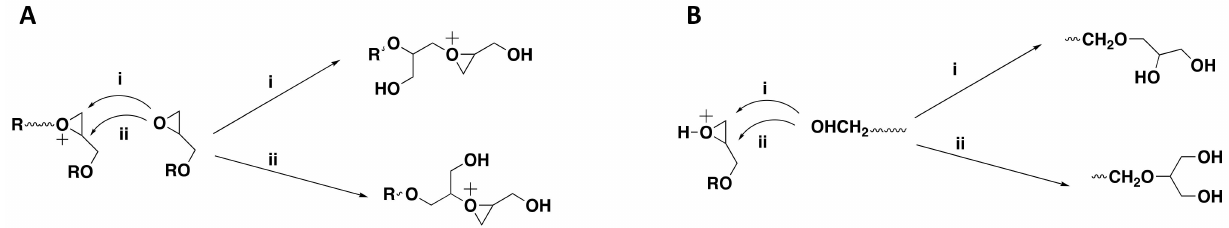
Figure 1. Proposed mechanism for CROP of glycidol based on ( A ) ACE and ( B ) AM. Adapted with permission from ref. [15]. Copyright 2017 Royal Society of